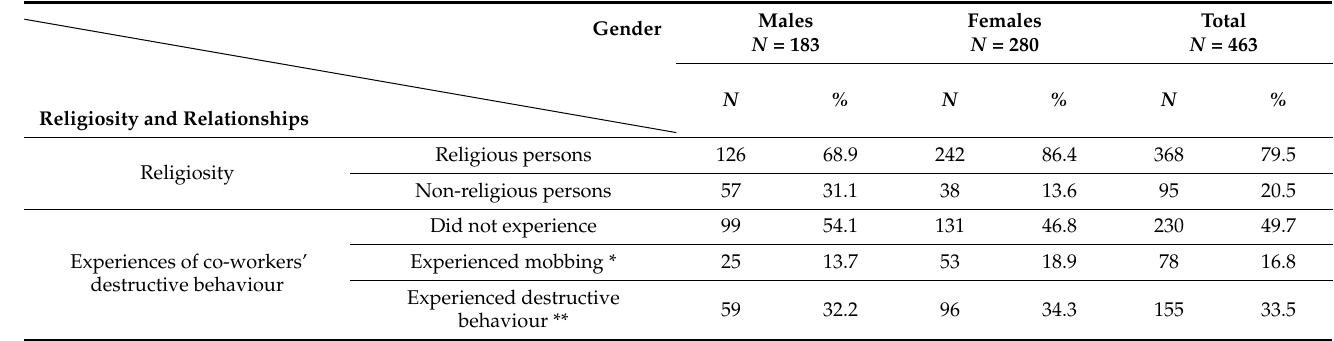
Table 1. Religiosity and experiences of co-workers’ destructive behaviour with regard to gender.